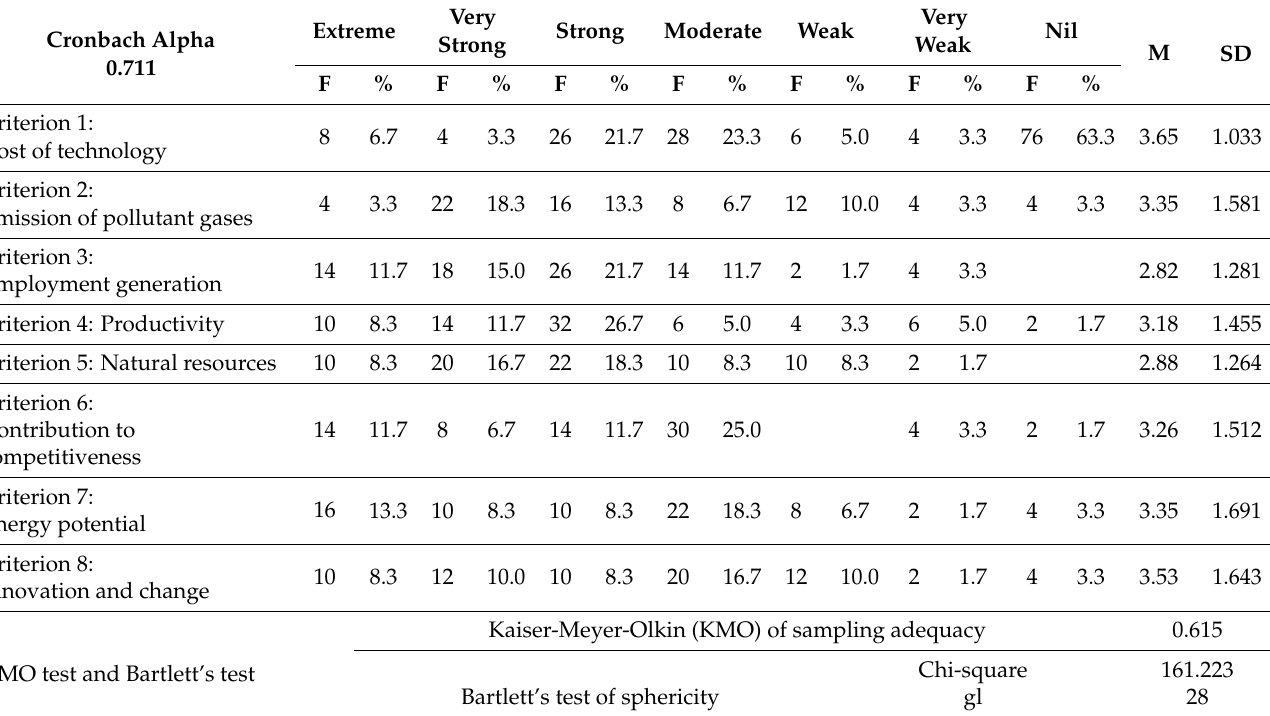
Table 14. Assessing the attractiveness of